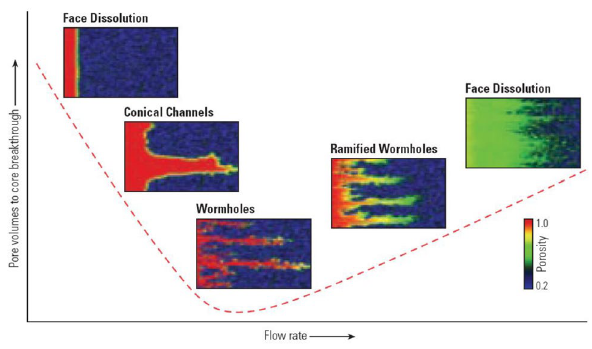
Fig. 1 Acidizing efficiency curve with different dissolution patterns (Fredd and Fogler